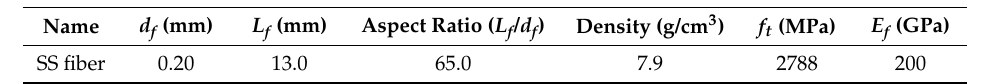
Table 3. Properties of steel